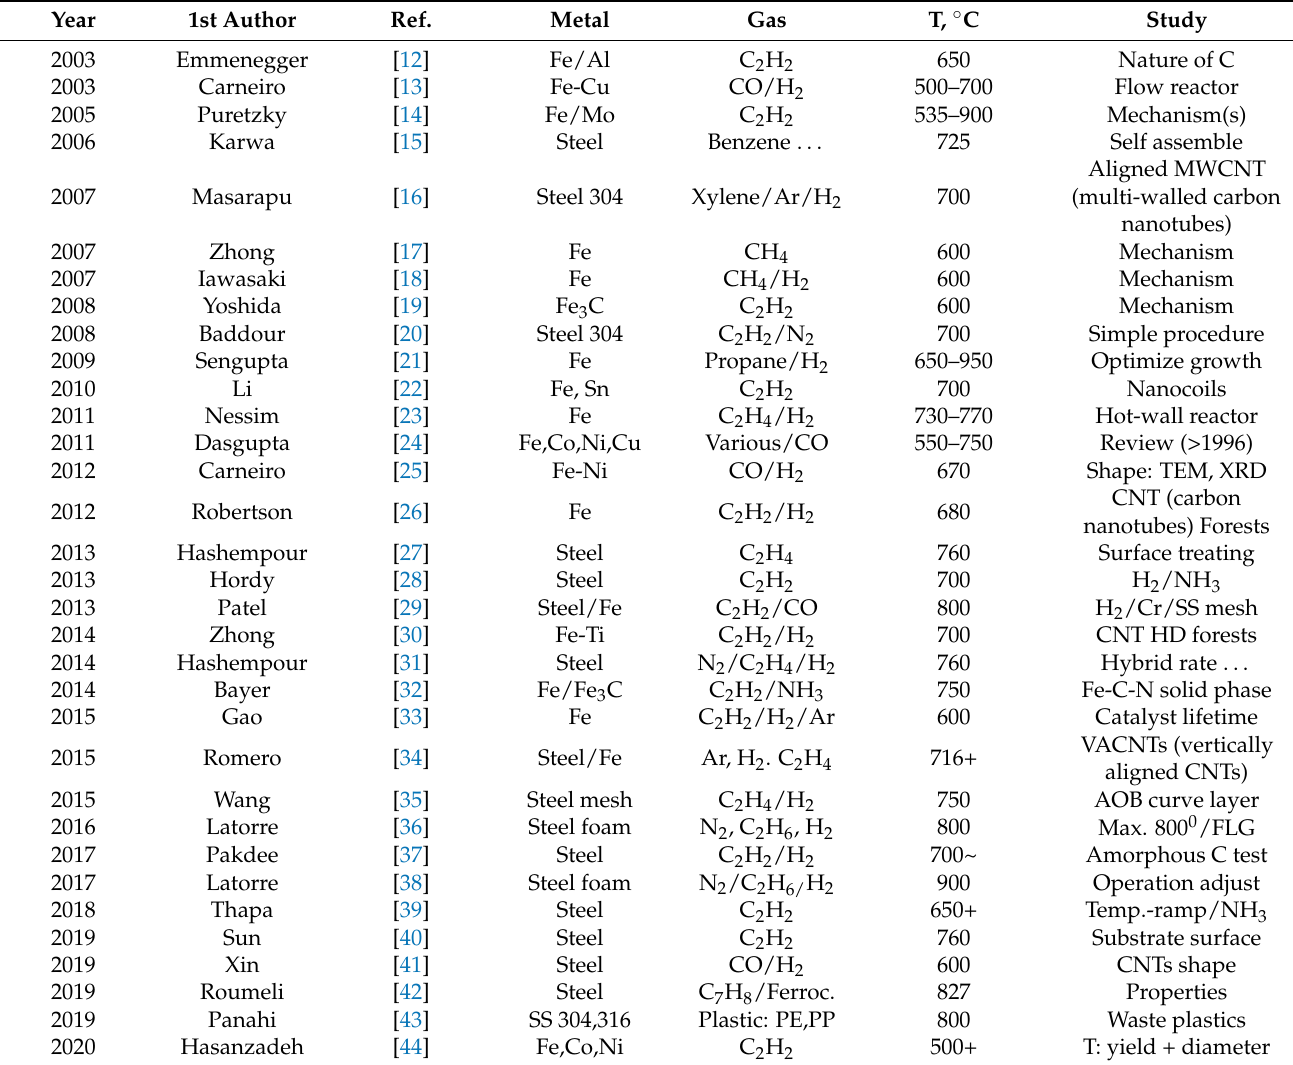
Table 2. Selection of recent publications on catalytic carbon formation on steel or Fe/Fe 3 C. The temperatures used by the various groups are close to the maximum rates observed in Figure